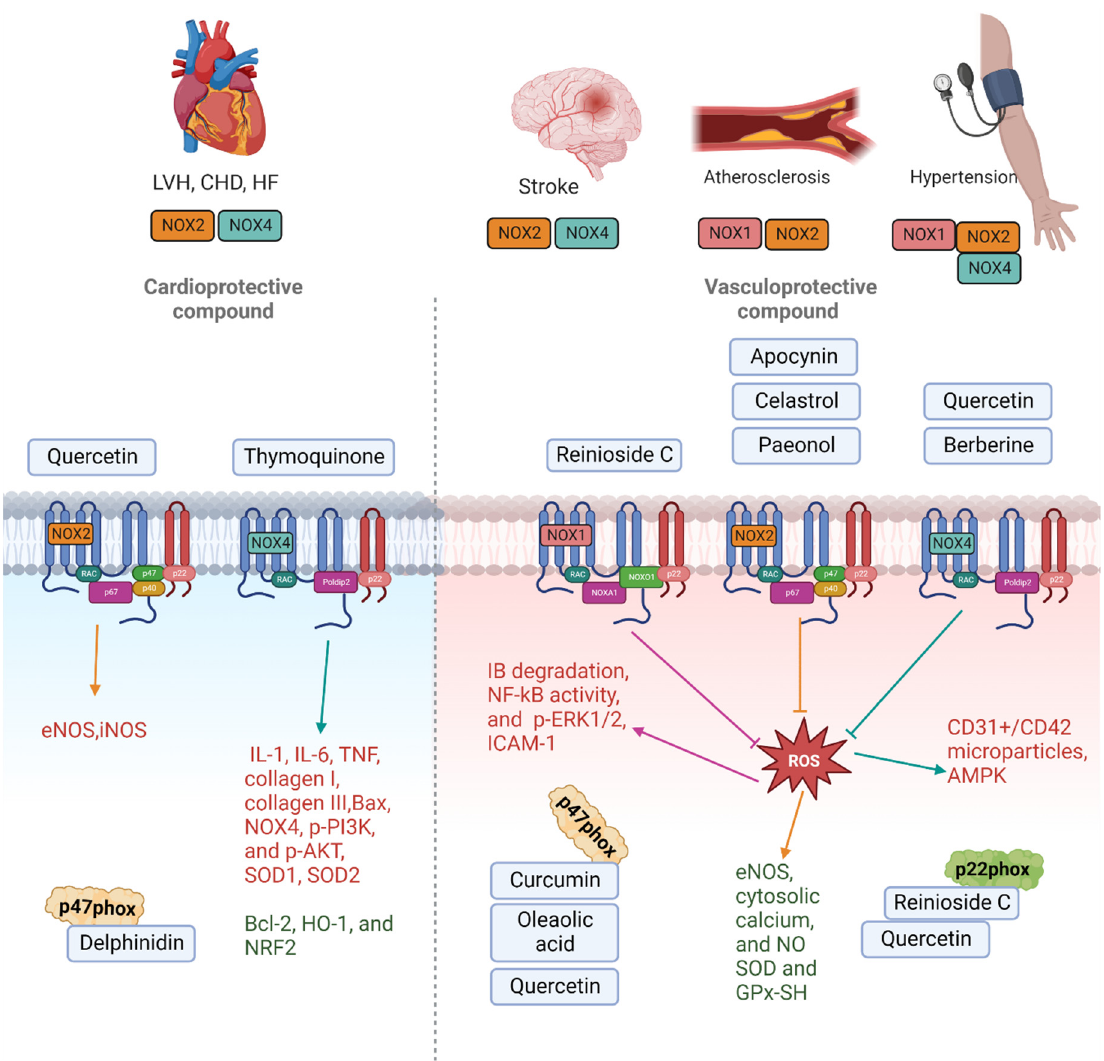
Figure 1. Schematic diagram of the NOX isoform-derived ROS production in cardiovascular dis- eases and natural products targeting those NOX isoforms leading to changes in intracellular targets. Natural products are divided into cardioprotective compounds targeting NOX2, NOX4, and p47phox, and vasculorprotective compound targeting NOX1, NOX2, NOX4, p47phox, and p22phox. The reduction in intercellular protein expression is noted in red font, while the upregula- tion of proteins is noted in green font in the diagram.